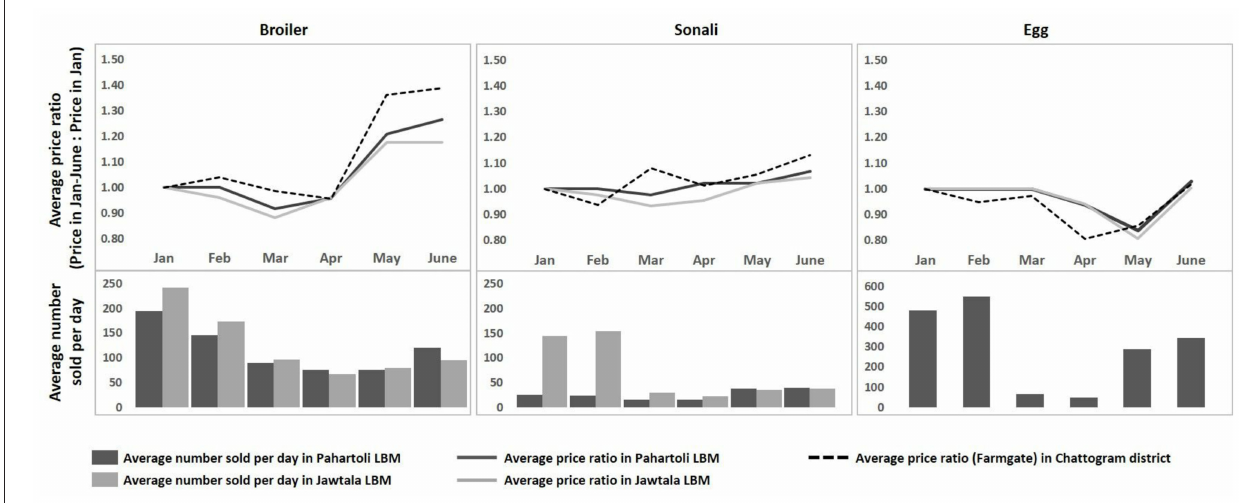
FIGURE 2 | Sales per day by volume, and retail and farm gate chicken and egg prices compared as reported in two live bird markets in Chattogram in January to June